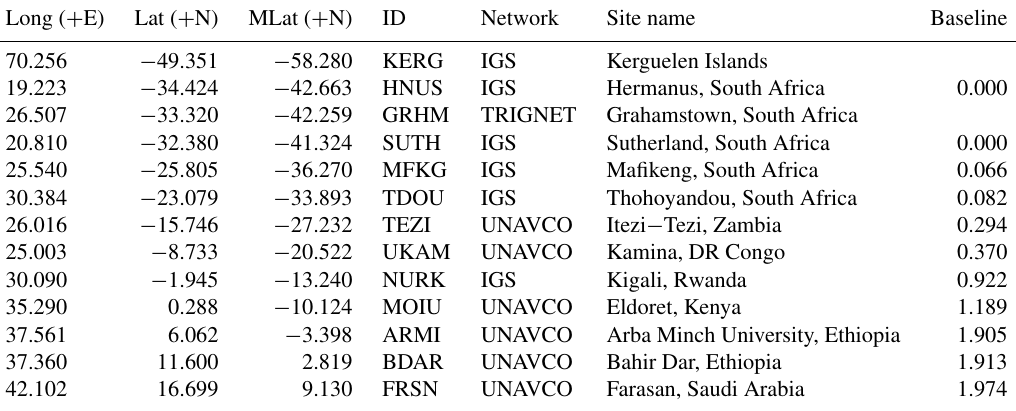
Table 1. The sites used for the Africa chain study, from south to north, with their supporting networks, and their derived plasmasphere baseline values (in TEC